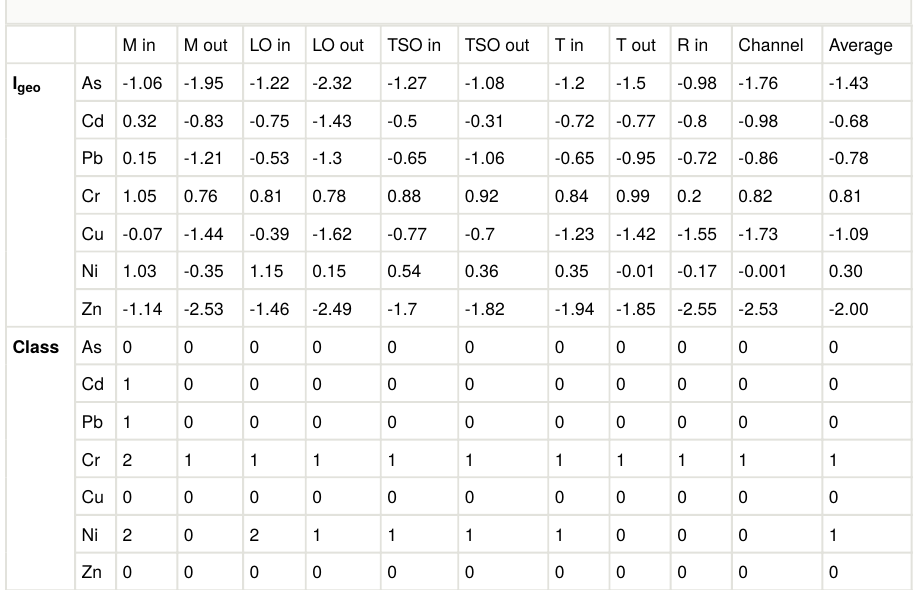
Table 2. The I index values and the enrichment class of each element per station.